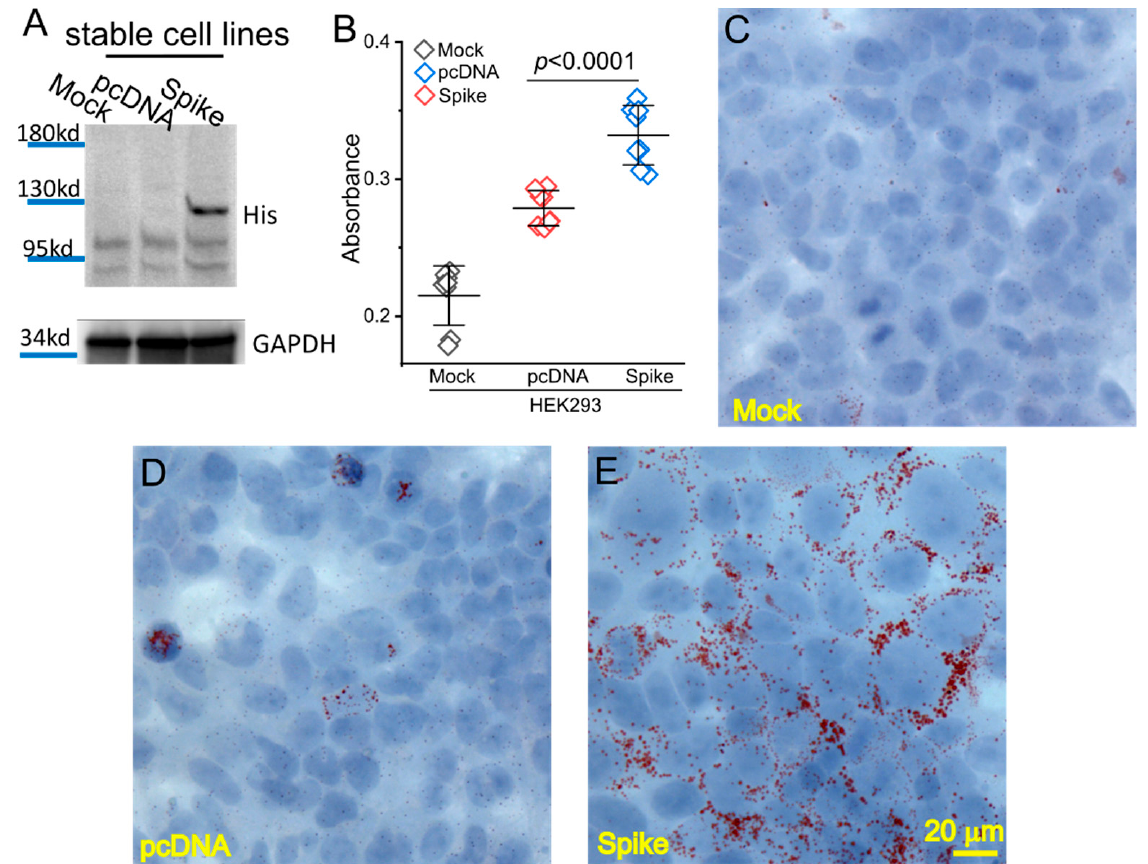
Figure 1. Spike protein caused lipid deposition in host cells. ( A ) Generation of Spike protein stable cell line. The expression of Spike protein was verified using an anti-His tag antibody in the Spike cells. ( B ) The quantification of Oil Red O staining in the mock, pcDNA, and Spike cells with measurement of an absorbance at 492 nm. ( C – E ) Histological images showing Oil Red O staining of lipid droplets in the mock ( C ), pcDNA ( D ), and Spike ( E ) cells. Nuclear components were counterstained by hematoxylin. We next examined transcriptional levels of a panel of 83 genes that are representative markers of lipid metabolism, autophagy, and ferroptosis (Supplementary Table S1). We found the mRNA levels of many lipid metabolic markers were upregulated such as propro- tein convertase subtilisin/kexin type 9 (Psck9), SREBF chaperone (Scap), Plin2, low density lipoprotein receptor-related protein 10 (Irp10), lecithin-cholesterol acyltransferase (lcat), low density lipoprotein receptor-related protein associated protein 1 (Irpap1), oxysterol binding protein-like 5 (Osbpl5), oxysterol binding protein-like 1A (Osbpl1a), protein kinase, AMP- activated, gamma 2 non-catalytic subunit (Prkag2), and mevalonate kinase (Mvk); while Serpinb2 was downregulated in the Spike cells (Figure 2A). For the examined autophagic and ferroptotic markers, Atg3, Atg7, Atg12, Nrf2, Phosphatidylinositol-4,5-Bisphosphate 3-Kinase Catalytic Subunit Alpha (Pik3ca), Pik3cd, Phosphoinositide-3-Kinase Regulatory Subunit 3 (Pik3r3), Acsl4, Fth1, glutaminase 2 (Gls2), and Ptgs2 showed an increase